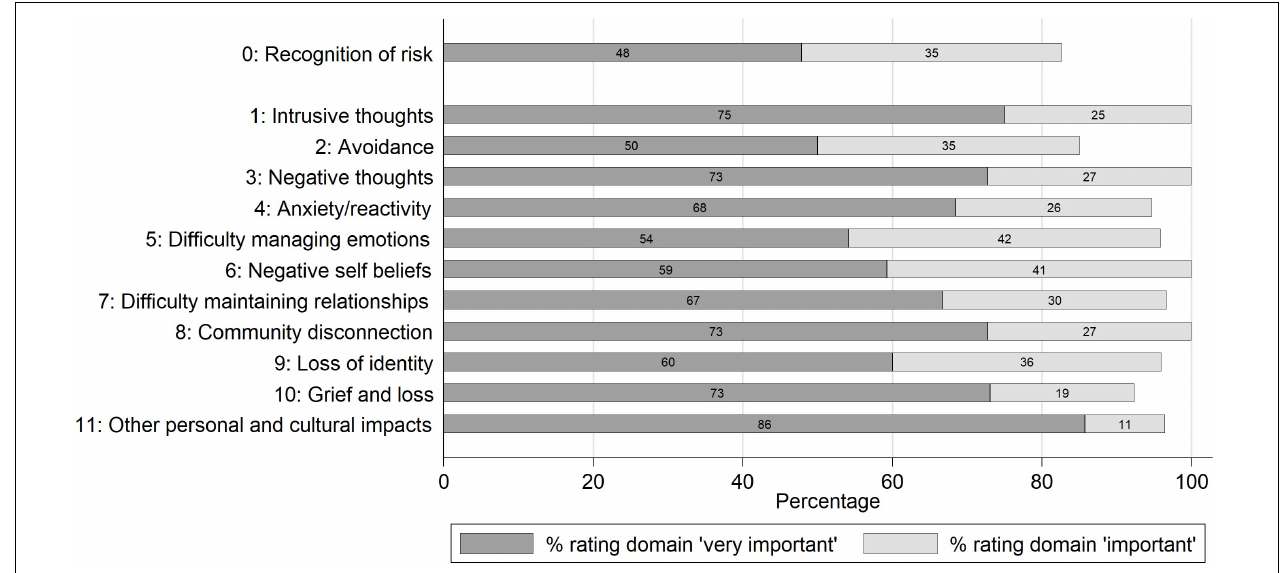
FIGURE 2 | Percentage of responses rating each domain as ‘very important’ or ‘important.’